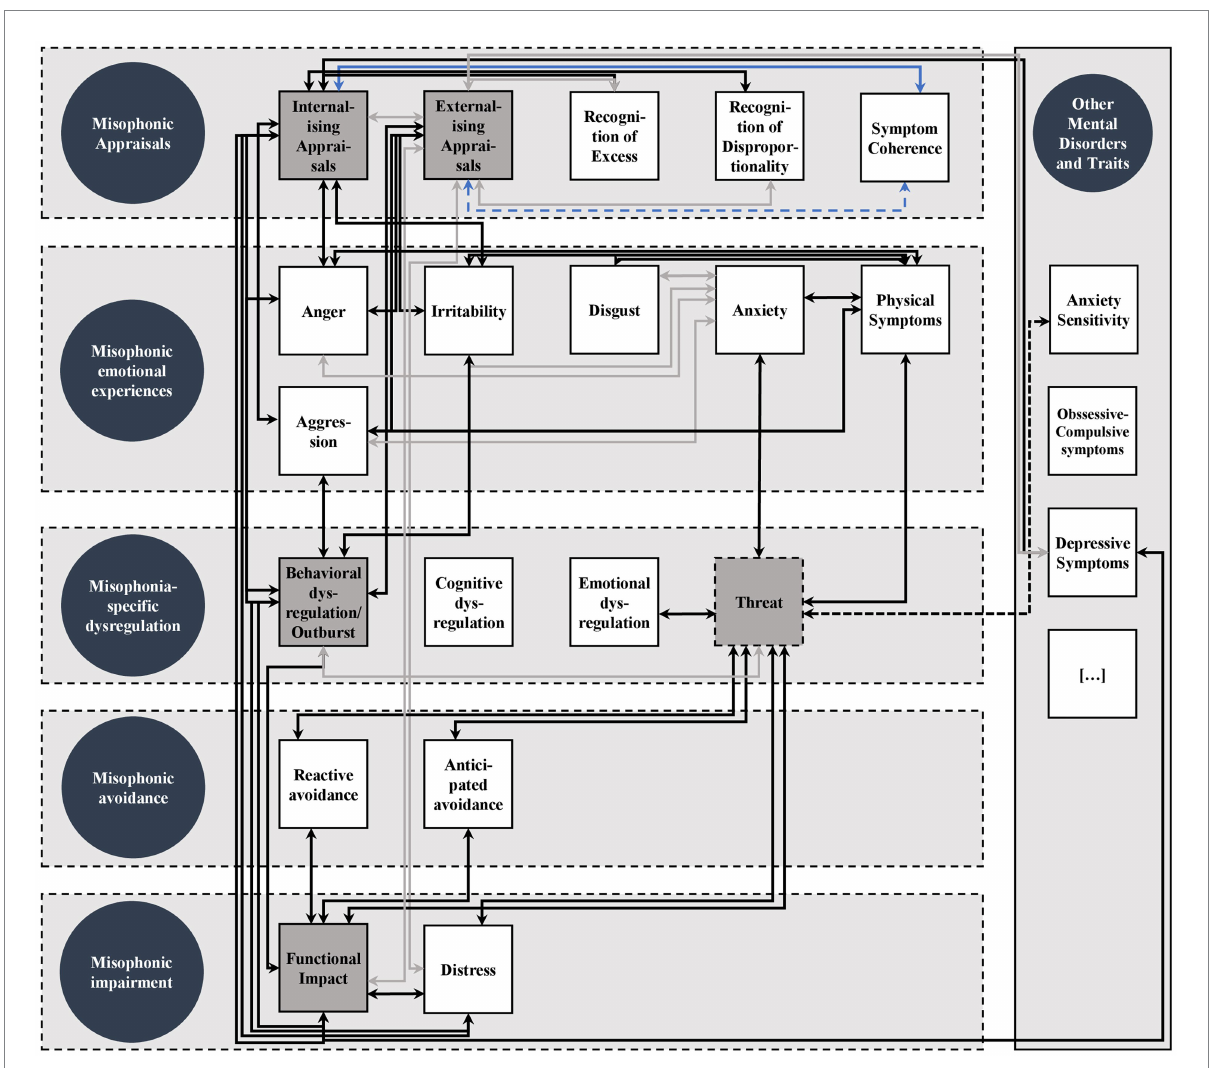
FIGURE 1 Core Nomological Network of Misophonic Symptoms. Circles represent proposed misophonic symptom domains. Squares represent specific misophonic symptoms. Grey squares represent symptoms being measured by the S-Five scales. Dashed lines around symptoms within symptoms domains shall indicate that symptom domains are not strictly separated. Strong associations are indicated by black arrows, weaker associations are grey, negative associations are blue with less negative associations in light blue, dashed arrows indicate